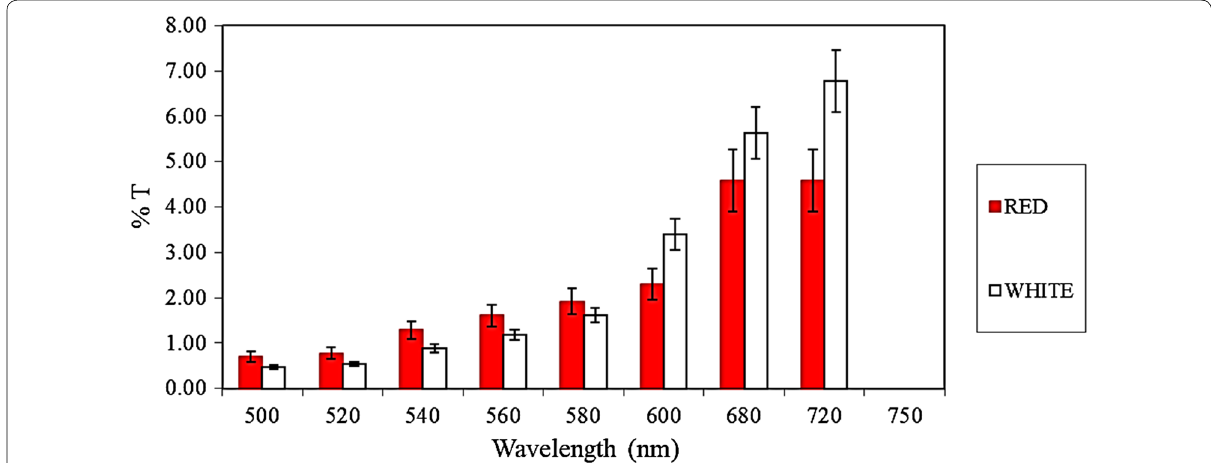
Fig. 3 Transmittance (%) of the two PLA-devices. Mean data from three determinations are shown. Bars indicate standard deviations (SD)